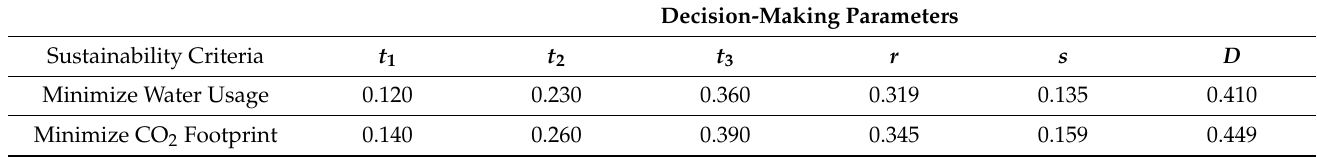
Table 2. Sustainability assessment of